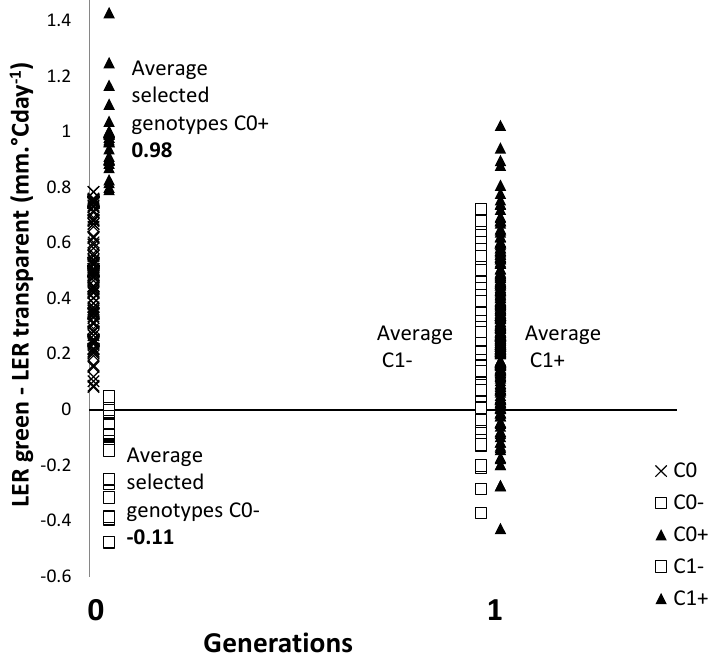
Figure 4. Divergent mass selection for LER in response to light (LER under green filter minus LER under transparent filter) in perennial ryegrass. Initial population: C0 and the next generation after intercrossing the selected genotypes: C1 (EU project